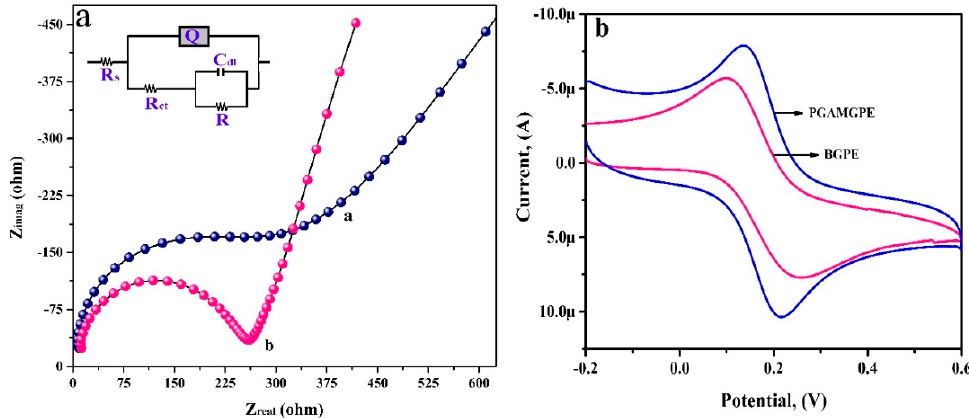
Figure 2. ( a ) Nyquist plot for BGPE (curve a) and PGAMGPE (curve b). ( b ) CVs representing K 4 [Fe(CN) 6 ] (1 mM) on BGPE and PGAMGPE in 0.1 M KCl at the scan rate of 0.1 V/s.